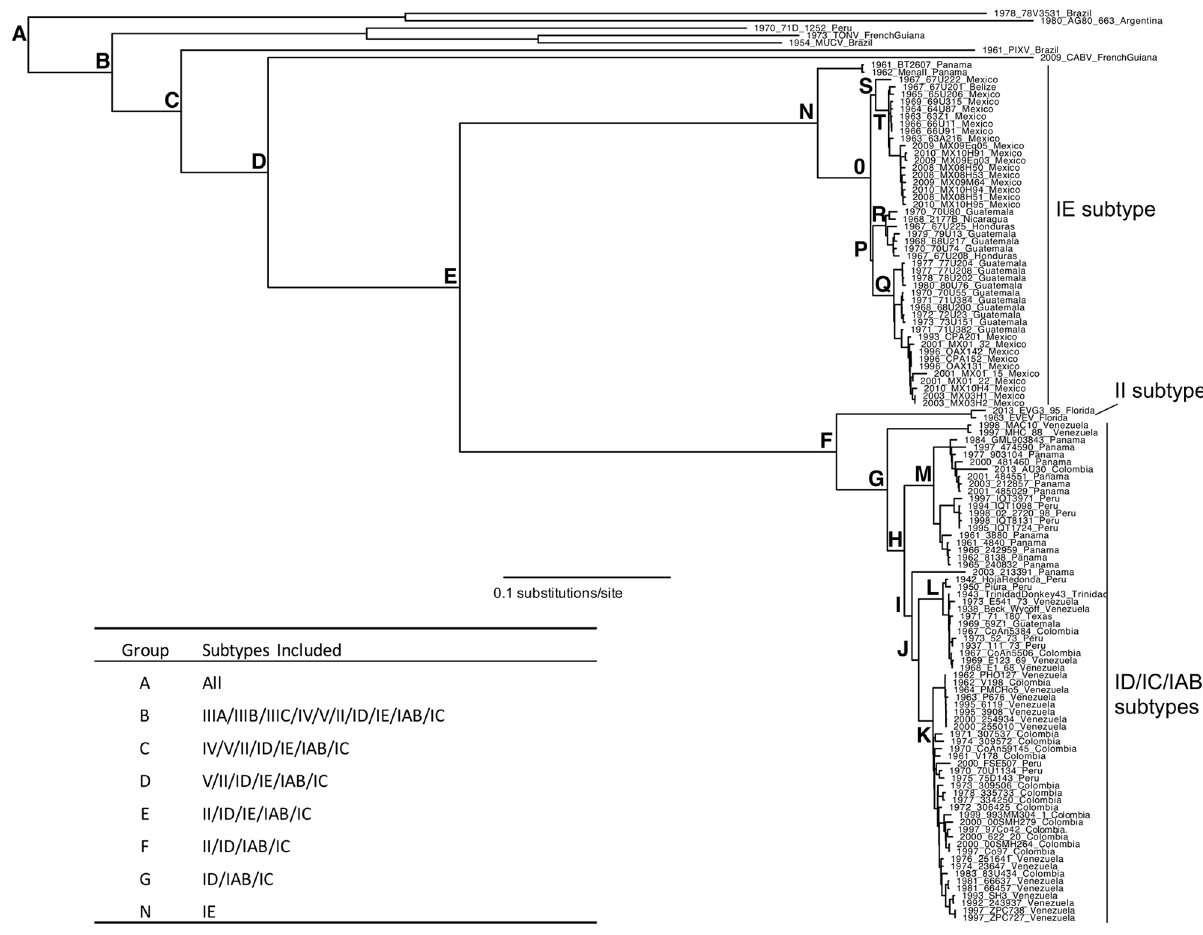
Fig 1. Maximum likelihood phylogeny for VEEV complex. Relevantinternal nodesare